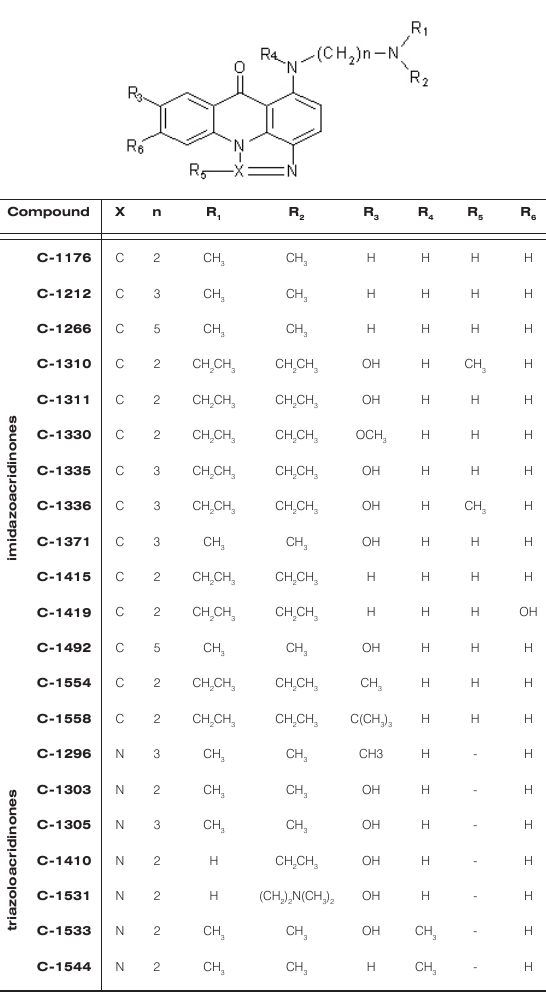
Fig. 1 . The values of all lipophilicity parameters, both experimentally determined from six HPLC columns (log k _Luna-log k _Zorbax), as well as eight calculated w w (AC_logP-XLOGP3) parameters for the compounds are